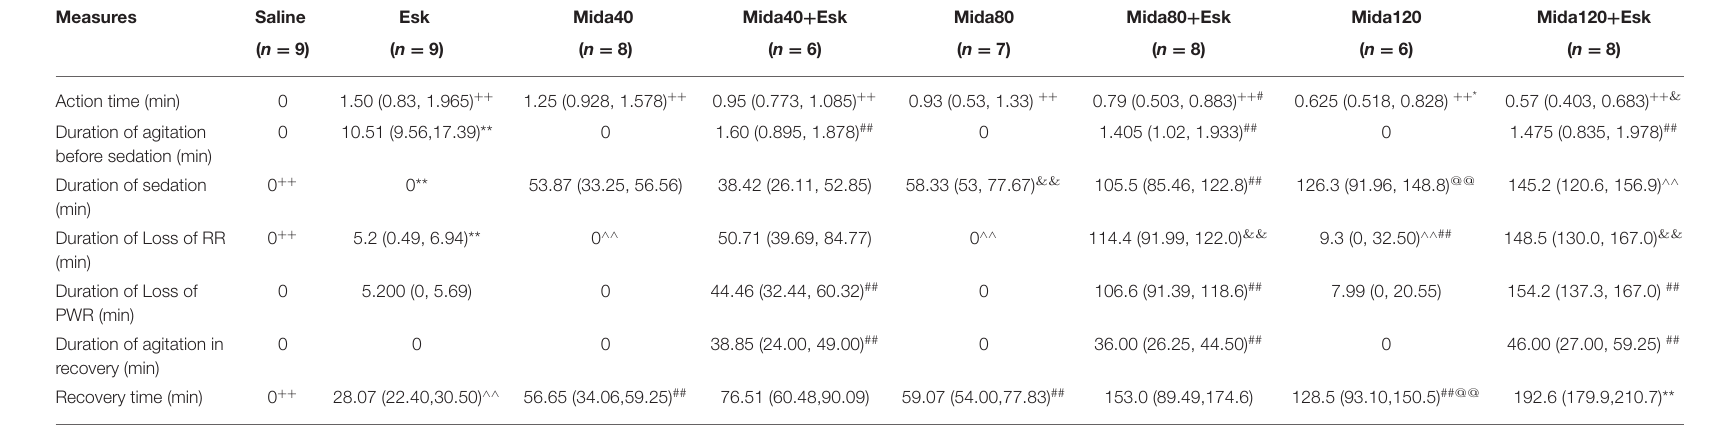
TABLE 2 | Results of behaviors observation [median (25percentiles, 75percentiles)].